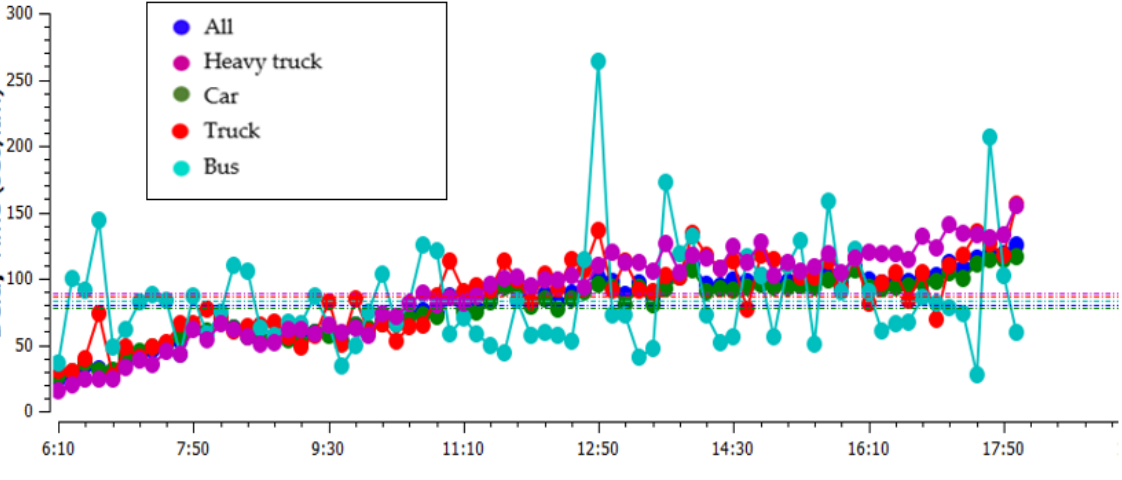
Figure 14. Delay time for each vehicle category—2021.